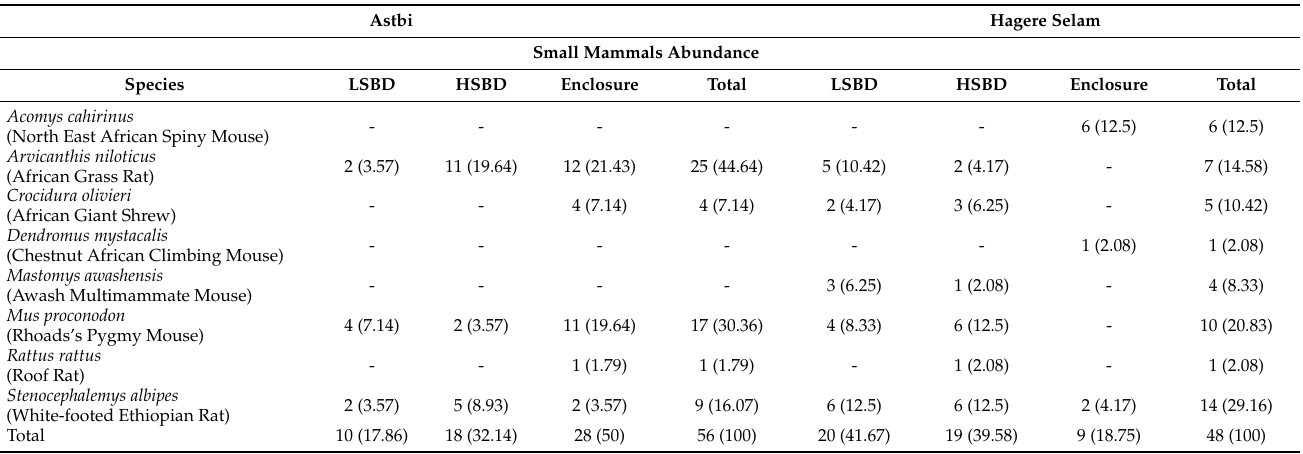
Table 2. Abundance (number of individual captures) of small mammals in the low stone bund density (LSBD) and high stone bund density (HSBD) fields and in the enclosures in Atsbi and Hagere Selam. Numbers in parentheses indicate relative abundances (%) of each species per study area.